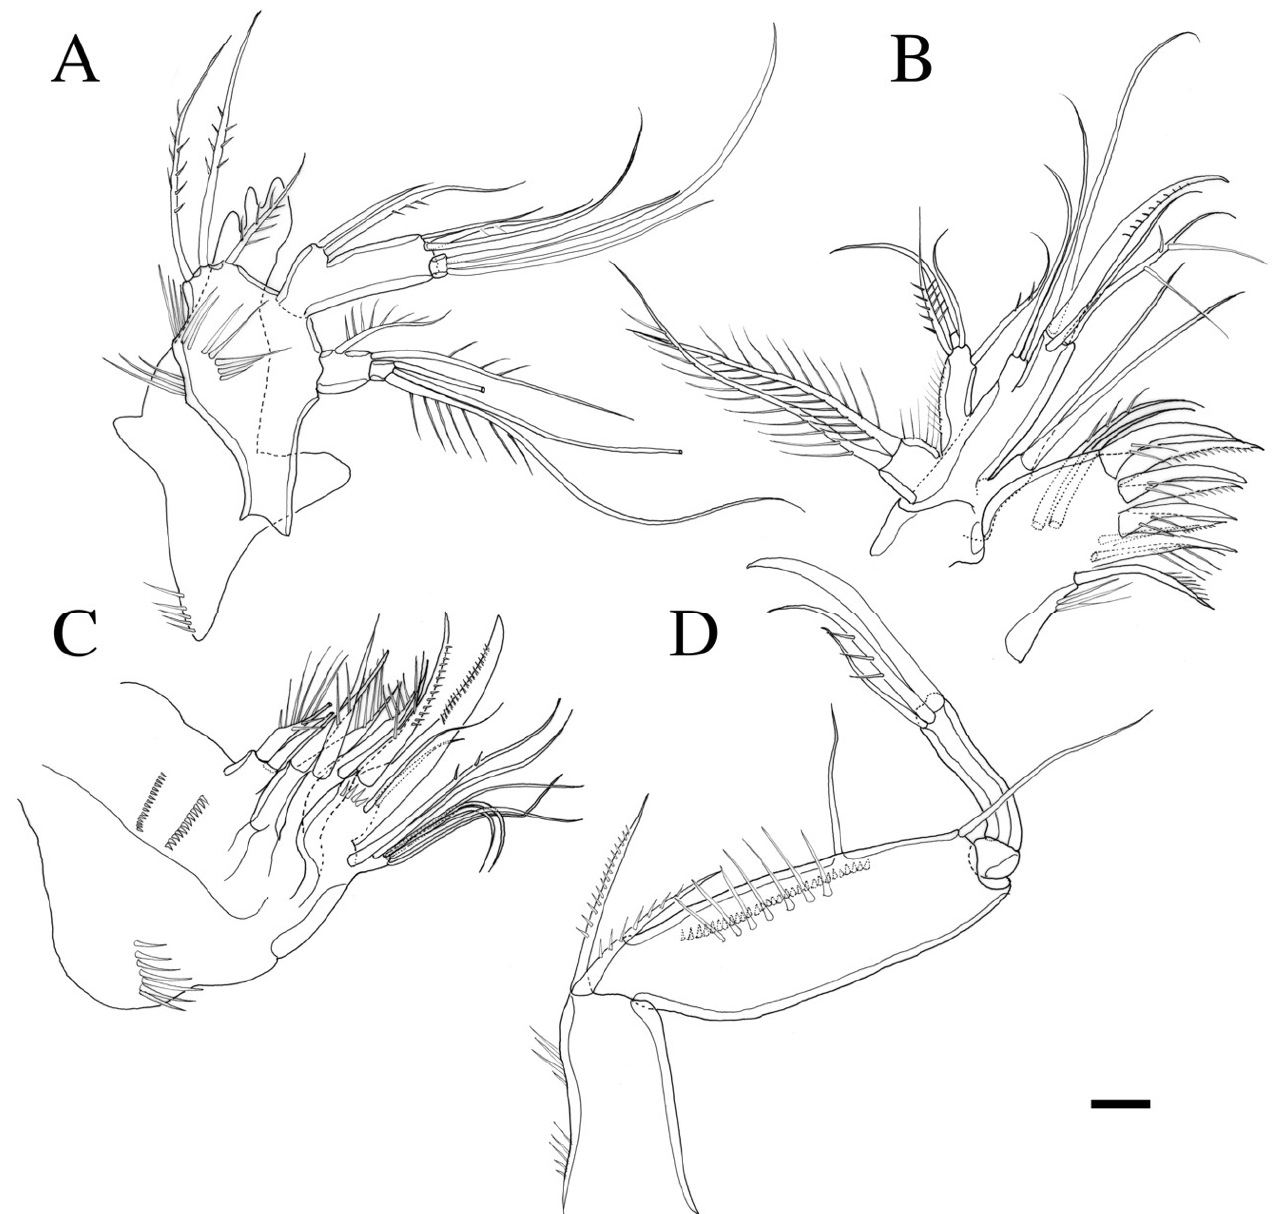
Figure 4. Robertgurneya jejuensis sp. nov. ( A ) Mandible. ( B ) Maxillule. ( C ) Maxilla. ( D ) Maxilliped. Scale bar: 10 μm.